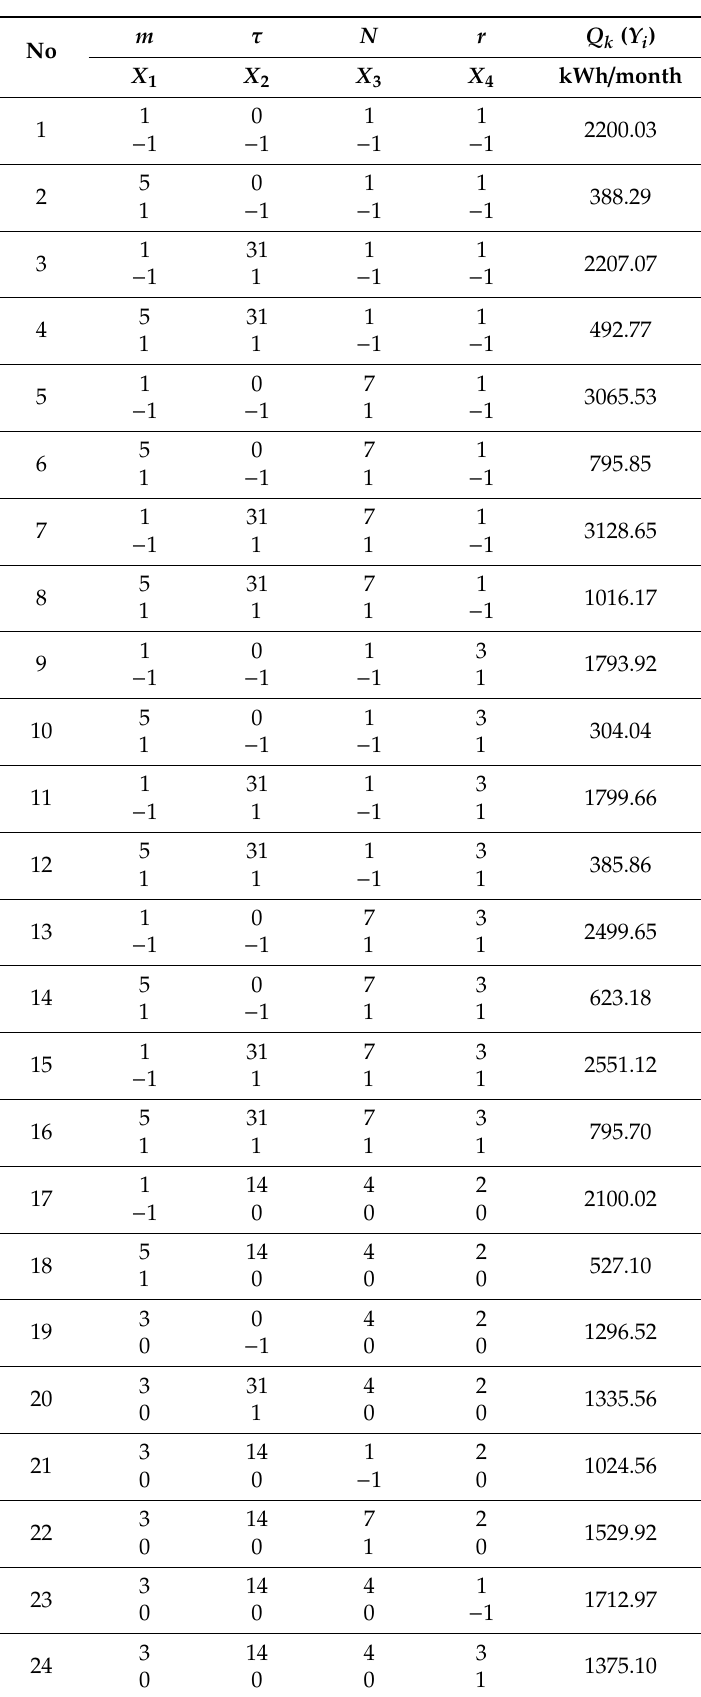
Table 3. Planning matrix and calculation results of Q k ( Y i